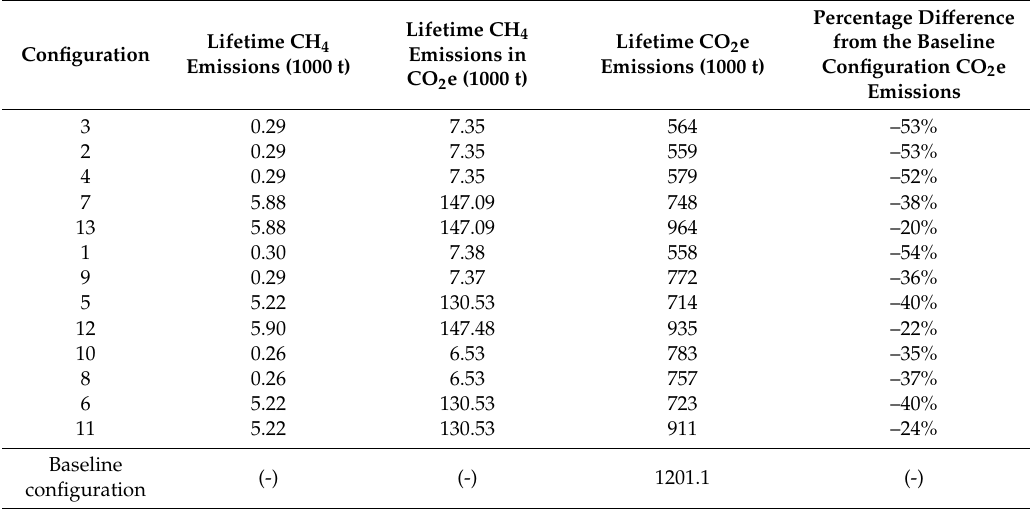
Table 13. Lifetime CO 2 equivalent emissions for the Aframax tanker power plant